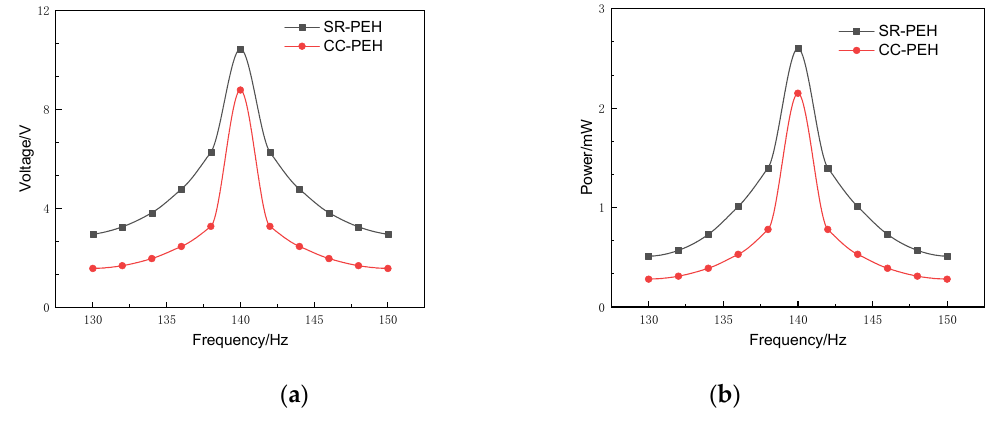
Figure 12. Output performance comparison. ( a ) Output voltage comparison; ( b ) Output power comparison.